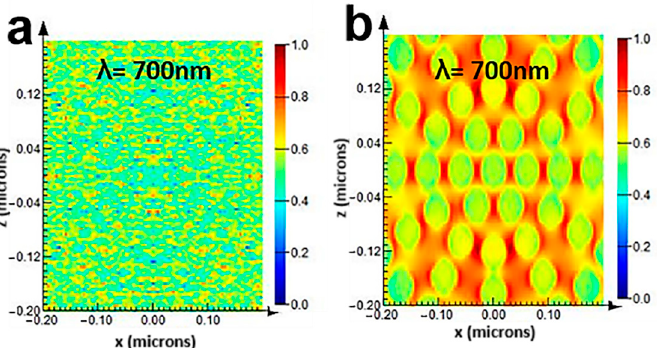
Figure 5. ( a ) The bulk TiO 2 /Perovskite compare to ( b ) TNWs/Perovskite truncated interface at 700 nm. 700